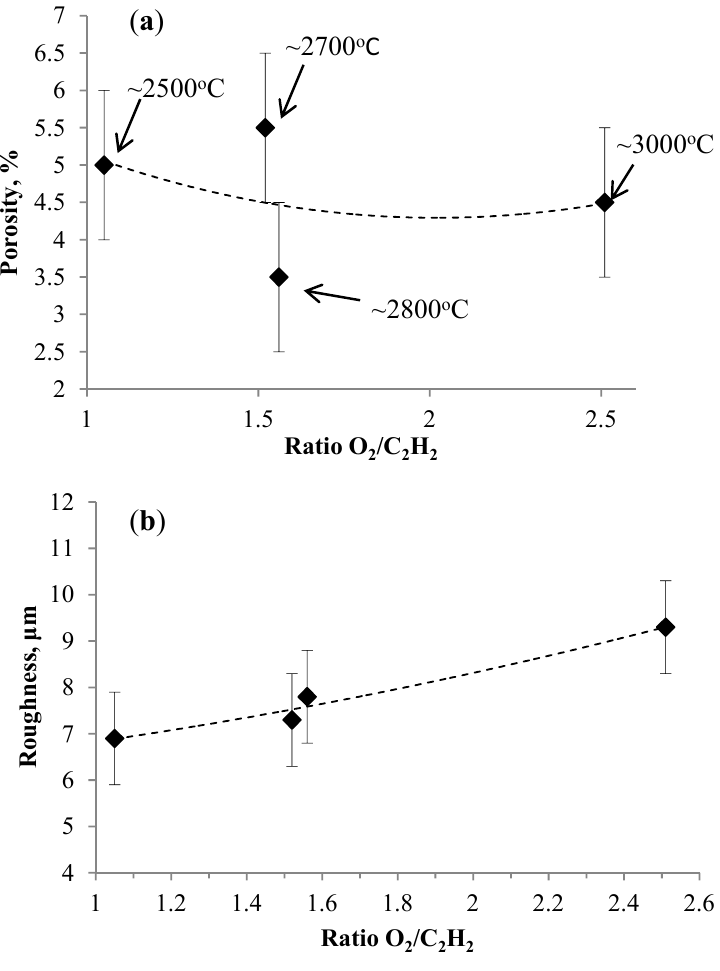
Figure 8. Dependence of the properties of Ni-Al coatings on O ( b ) roughness and ( c ) adhesion strength and erosion rate. Flame temperatures shown are